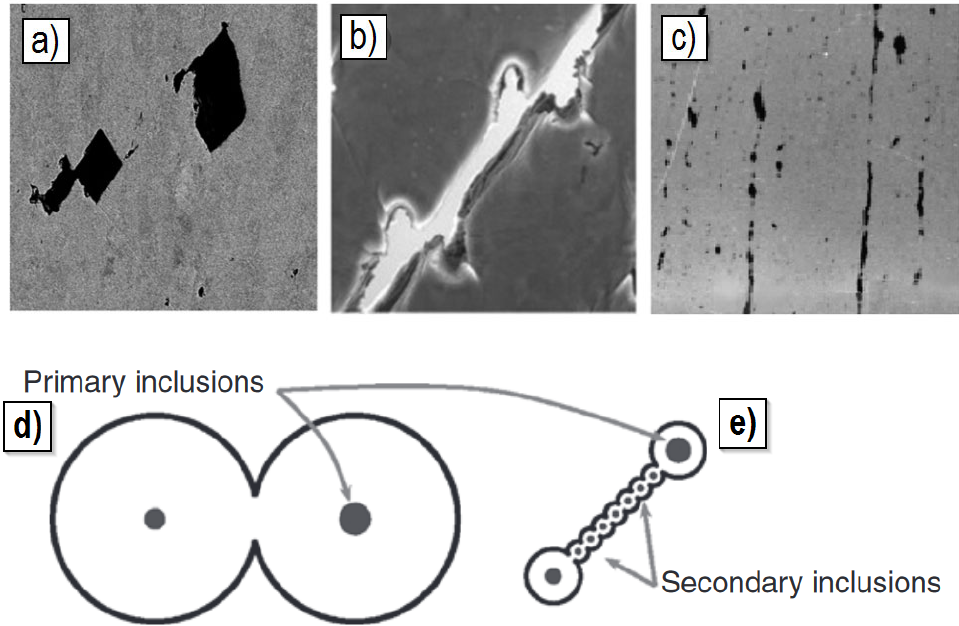
Figure 11. Methods of realising void coalescence in materials (example in steel): ( a , d ) Internal necking; ( b , e ) Shear coalescence; ( c ) Necklace coalescence [24,78,79].